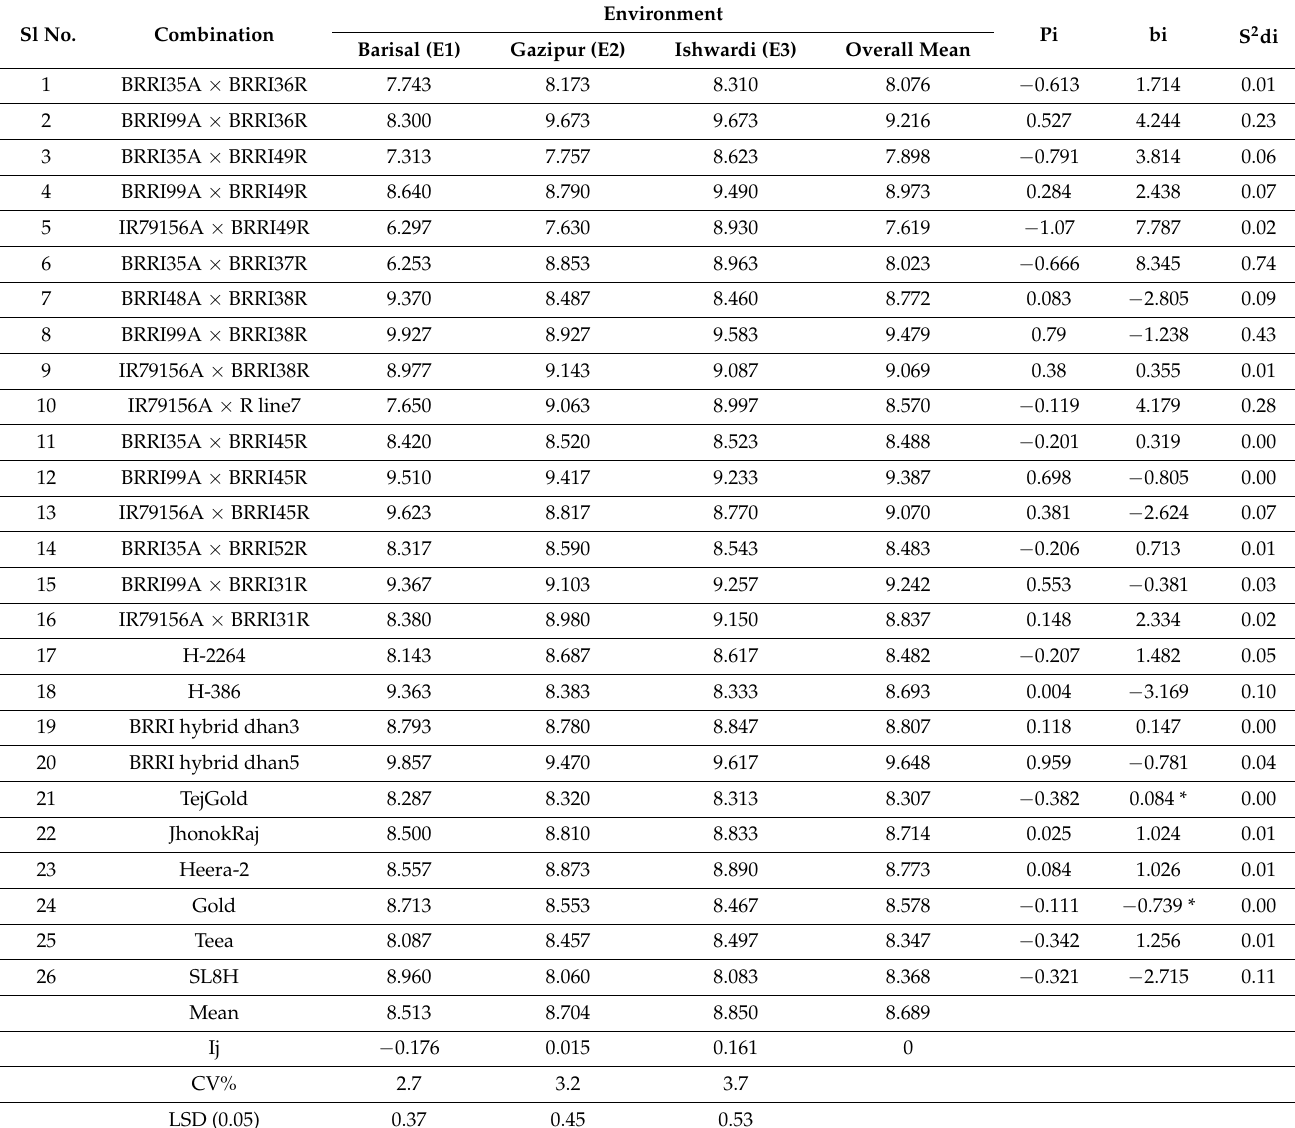
Table 11. Stability analysis for grain yield of 26 hybrid combinations at three